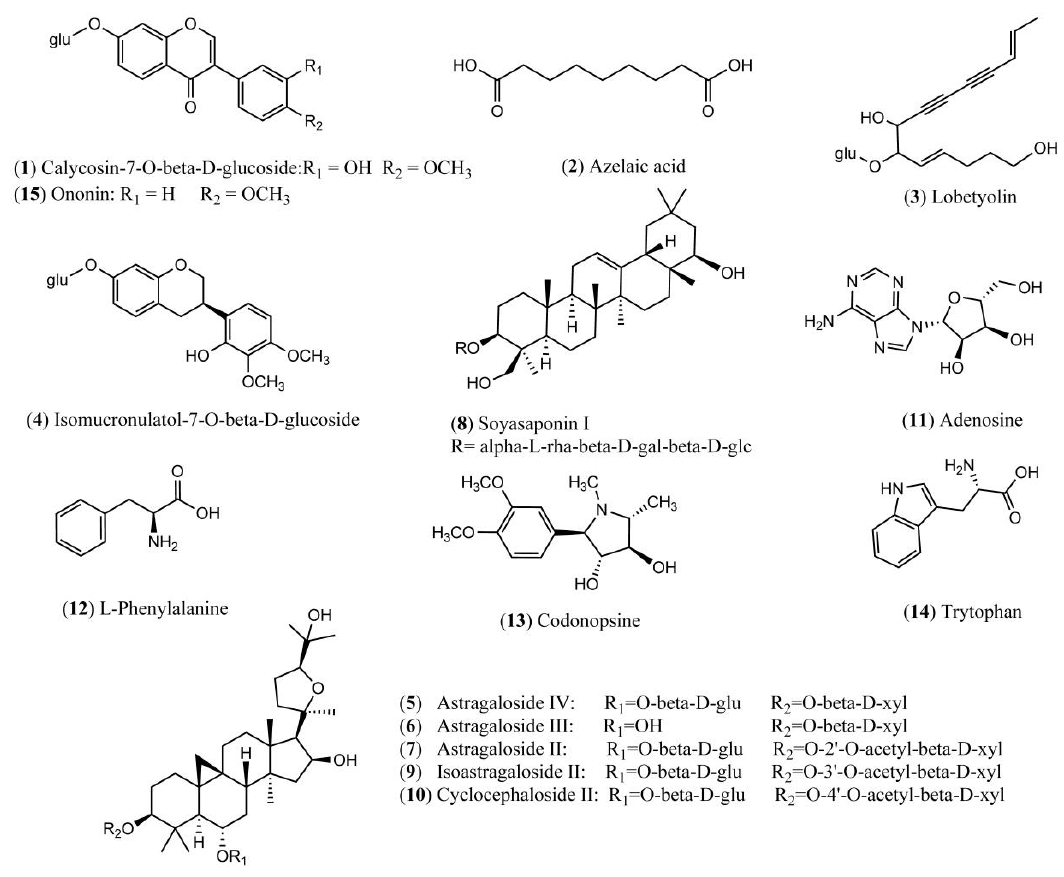
Figure 1. Chemical structures of 15 identified non-sugar small molecules.